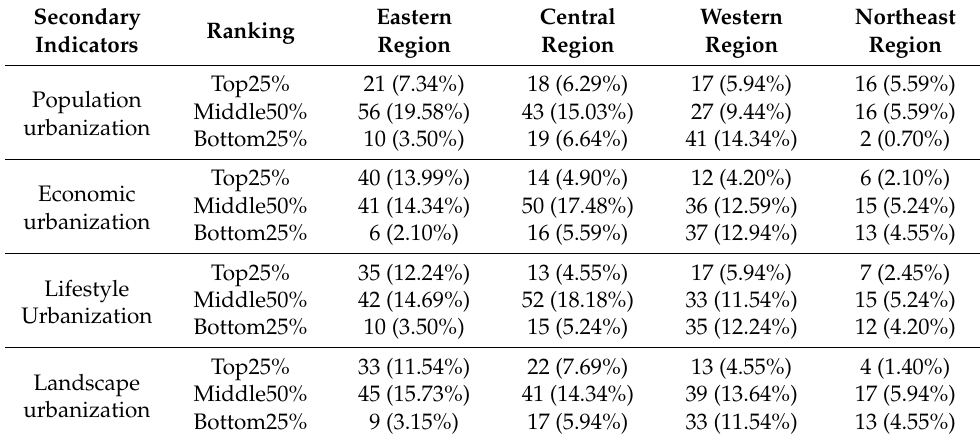
Table 5. Secondary indicators score of urbanization.